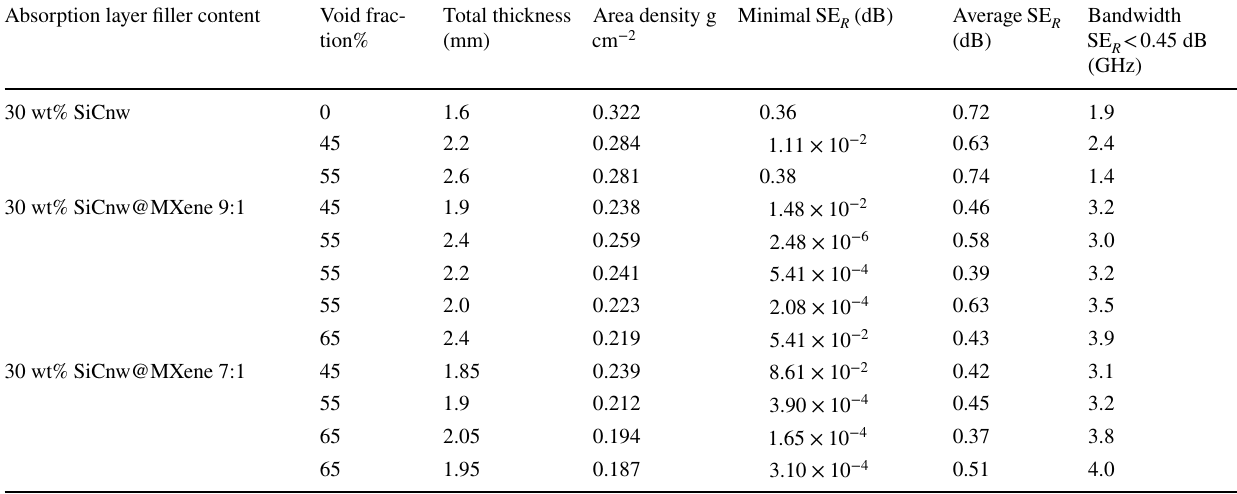
Table 1 EMI shielding properties for layered foam/film PVDF nanocomposites with various filler compositions, VF and absorption layer thick-